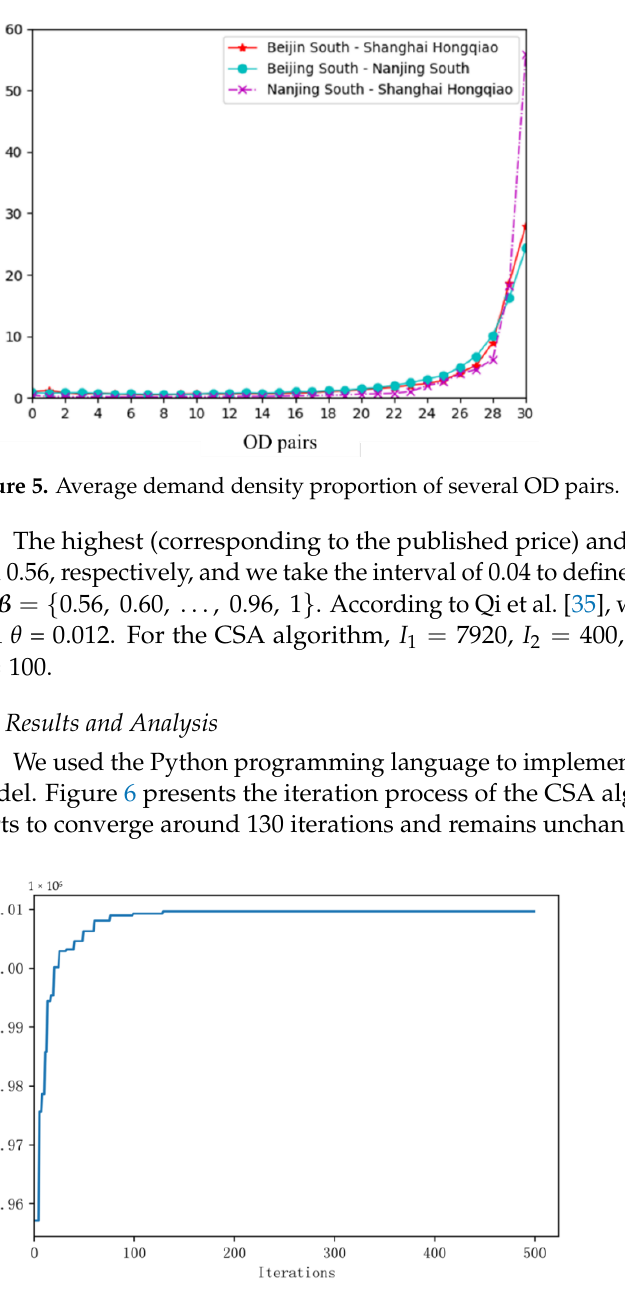
Figure 7. The optimized train stop plan. Under the fixed operational mode, the passenger flows of G11, G19, G21, and G113 are 1157, 1002, 1113, and 1239, respectively. After optimization, the passenger flows of G11 and G21 increase to 1334 and 1441, while those of G19 and G113 decrease to 705 and 780, respectively. The reason is that G11 and G21 can serve more OD pairs. Conversely, as G19 and G113 reduce stops at several intermediate stations, they no longer serve part of the OD pairs. As a result, the passenger flow of these OD pairs transfers to G11 and G21. Table 6 gives the optimal dynamic pricing strategy for some ODs (the ticket price is accurate to 0.5 yuan). For any OD, the closer the period is to the departure date, the higher the ticket price. The dynamic price is lower than the fixed price for the first two periods, while it is higher for the last two periods. This is because passengers are generally more sensitive to the ticket price during early ticket pre-sale time, so the passenger demand is